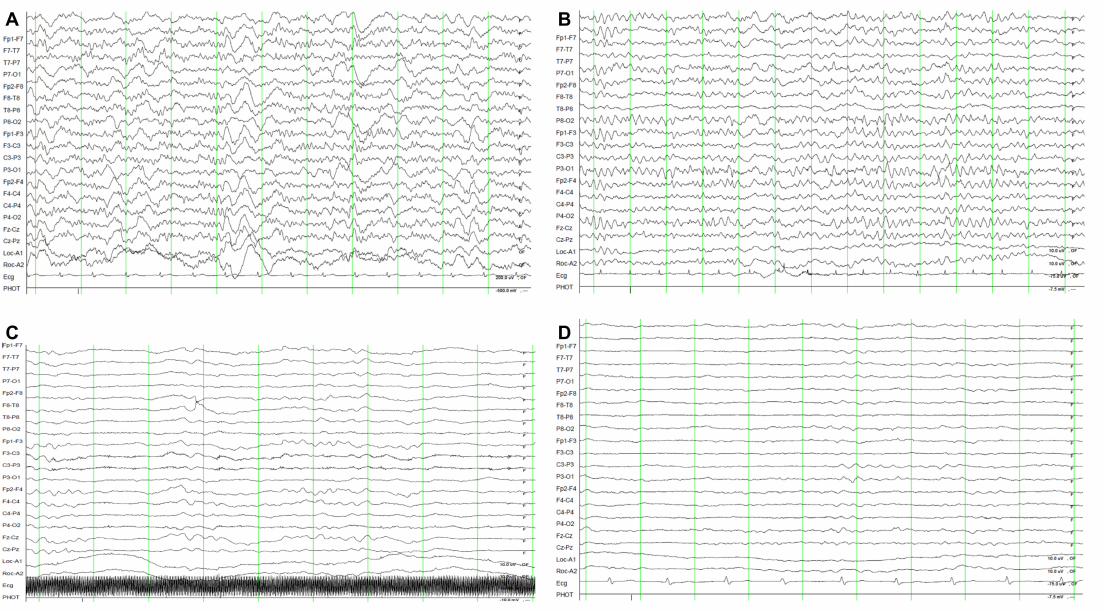
Figure 1. Example of predominant background electroencephalography frequency in out-of-hospital cardiac arrest survivors subjected to targeted temperature management. ( A ) Predominant alpha waves; ( B ) predominant theta waves; ( C ) predominant delta waves; ( D )